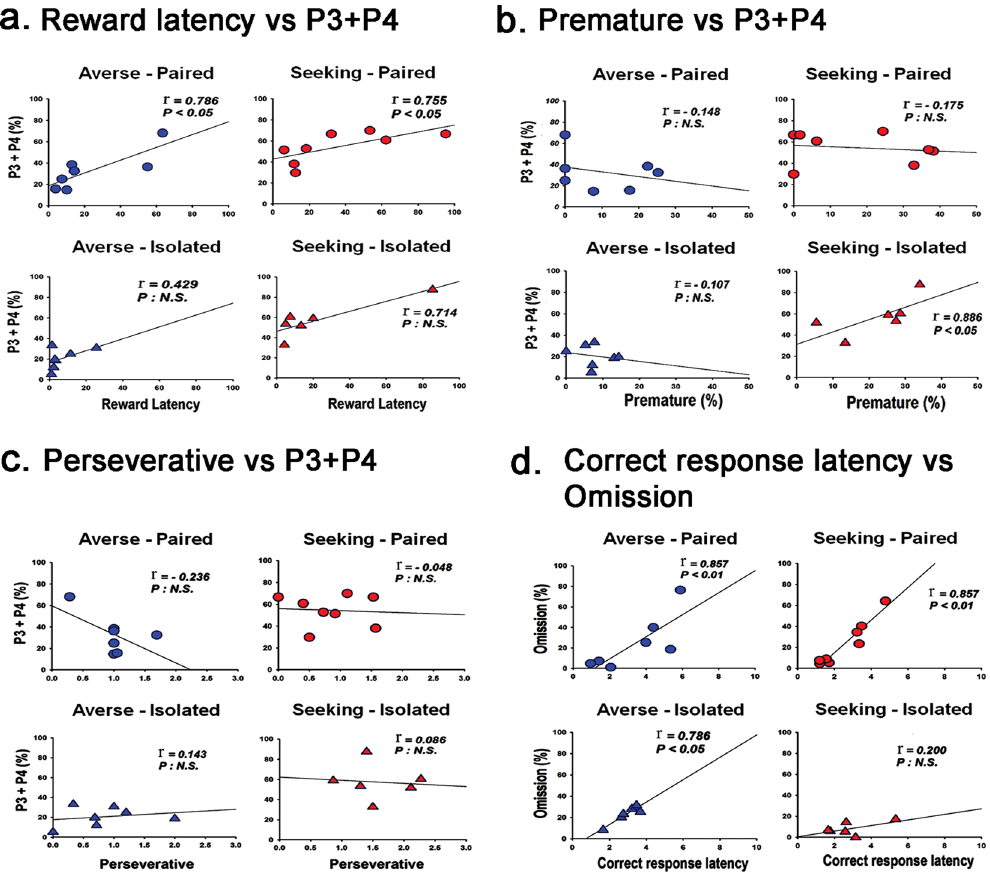
Figure 5. Correlation analysis of behavioral parameters. Correlation was analyzed using the Spearman rank- order on data obtained from cocaine pre-exposed and cocaine challenged rats. ( a ) A significant correlation was observed between reward latency and the P3 + P4 combined score (i.e., the disadvantageous choice) in the averse-paired and seeking-paired group. ( b ) There was only a significant correlation between premature responses and the P3 + P4 combined score in the seeking-isolated group. ( c ) There was no significant correlation between the perseverative response and P3 + P4 combined score in any group. ( d ) There was a significant correlation between the correct response latency and omission in all the groups, except the seeking- isolated